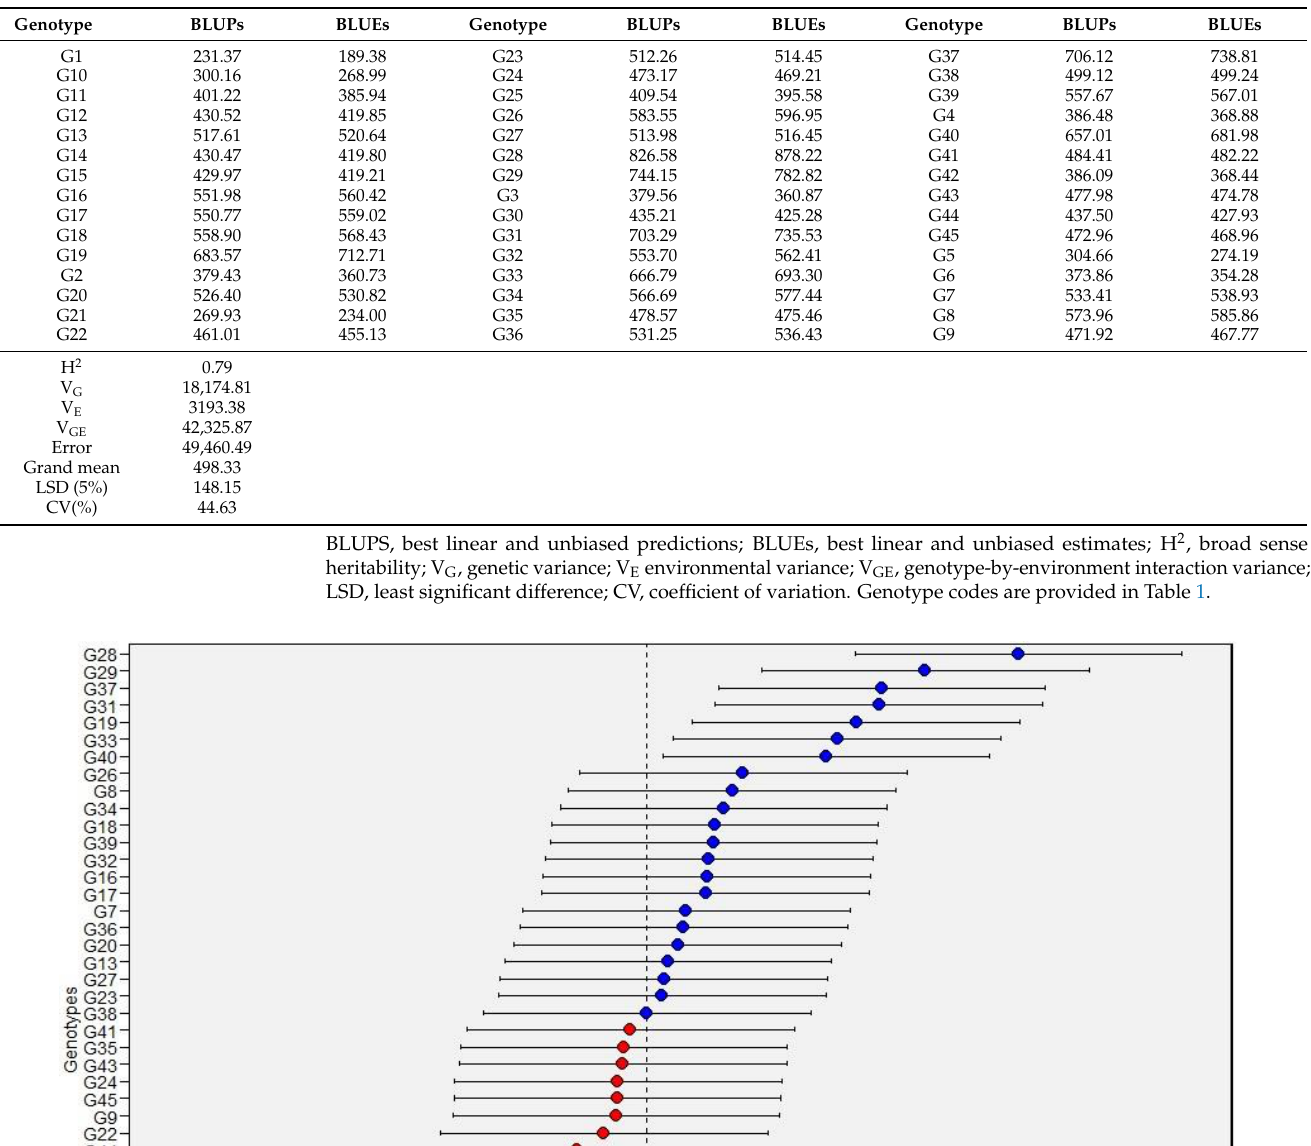
Table 6. Best linear and unbiased predictions (BLUPs) and best linear and unbiased estimates (BLUEs) in kg/ha of 45 tepary bean accessions evaluated across four environments in Malawi.